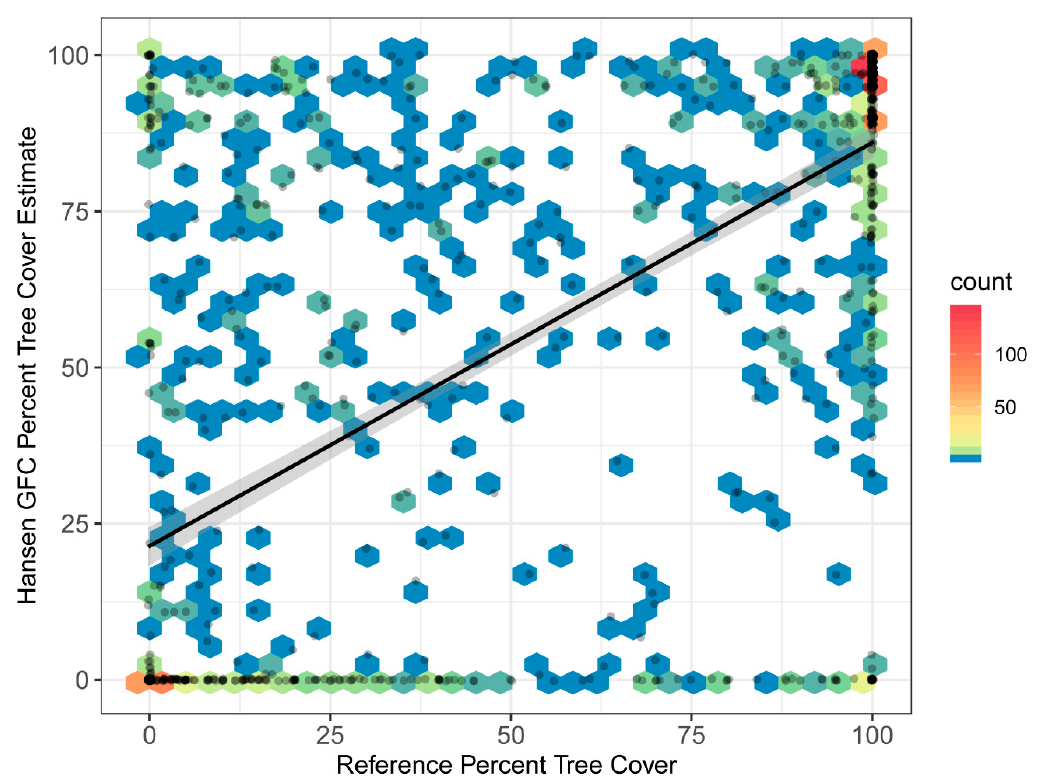
Figure 3. Percent tree cover accuracy for the GFC product, evaluated by comparing reference tree cover to tree cover predicted by the GFC. Because of overplotting, the point data are shown in two ways. The hexagons represent binned counts of point data, with the color of a hexagon representing the point count in that hexagon. The original data are indicated by semi-transparent grey points. The black line indicates a significant mean fit for an untransformed linear regression, and the gray region indicates the confidence intervals for the prediction.